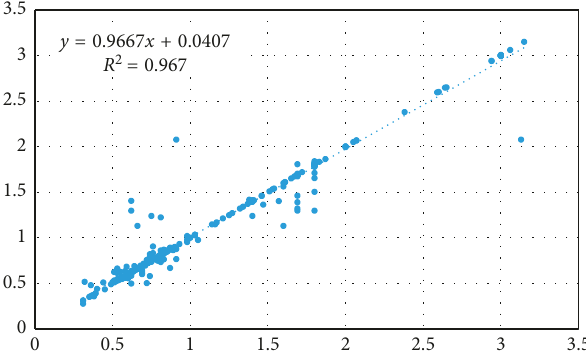
Figure 13: ANN U-opaque prediction results for all building types (ANN with additional building type